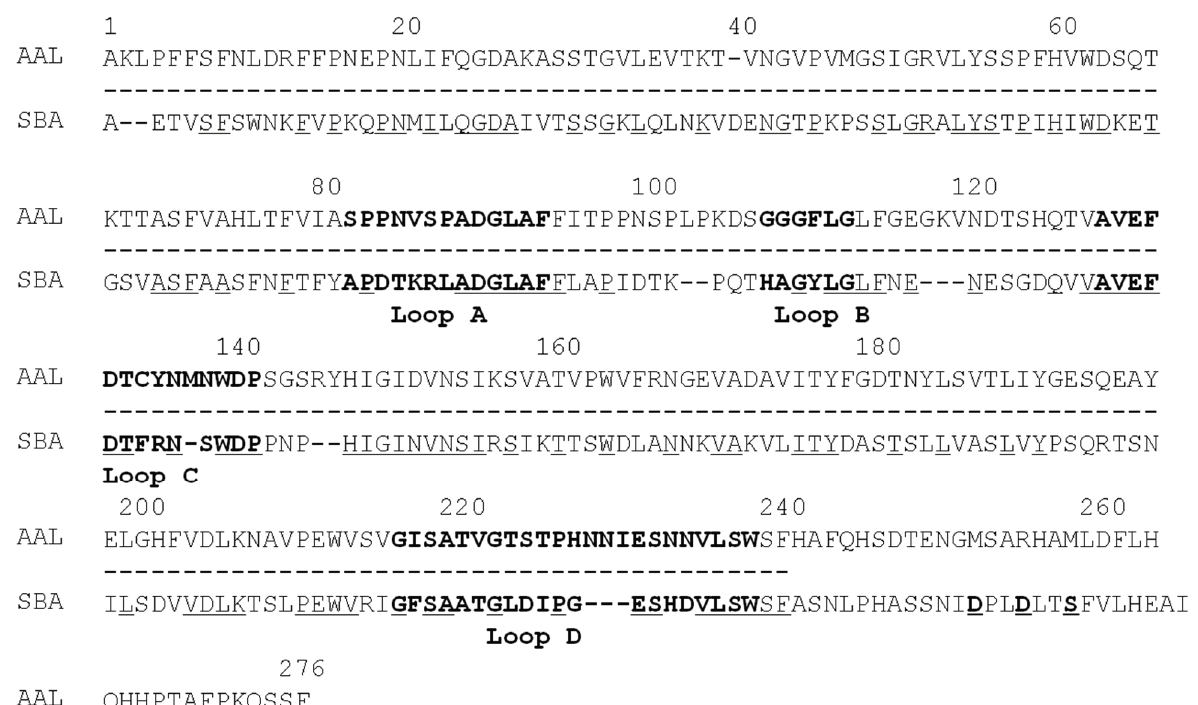
Figure 6. Sequence comparison of Apios tuber lectin (AAL) with soybean lectin (SBA). Identical amino acid residues are underlined beneath the sequence of SBA. The broken lines under the sequence of AAL are the sequence which was confirmed by direct sequencing of ATL using a protein sequencer in this study. Loops A-D are indicated by boldface letters. Asp (D) 240, Asp (D) 243, and Ser (S) 246 are putative truncating sites of SBA [24]. The amino acid sequence of AAL deduced from cDNA sequencing is cited from reference